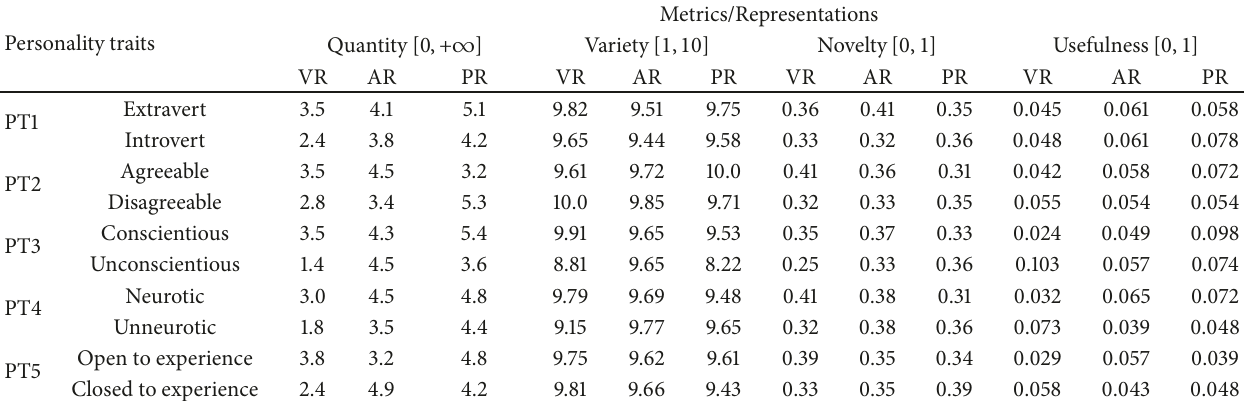
Table 2: Results of the